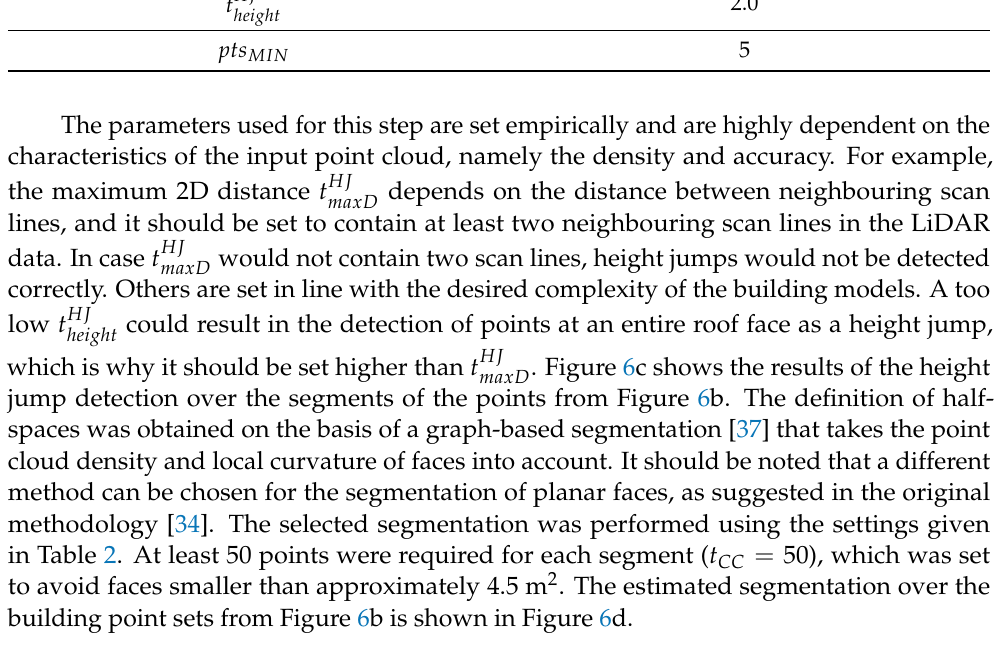
Table 2. Parameters used for segmentation of the point